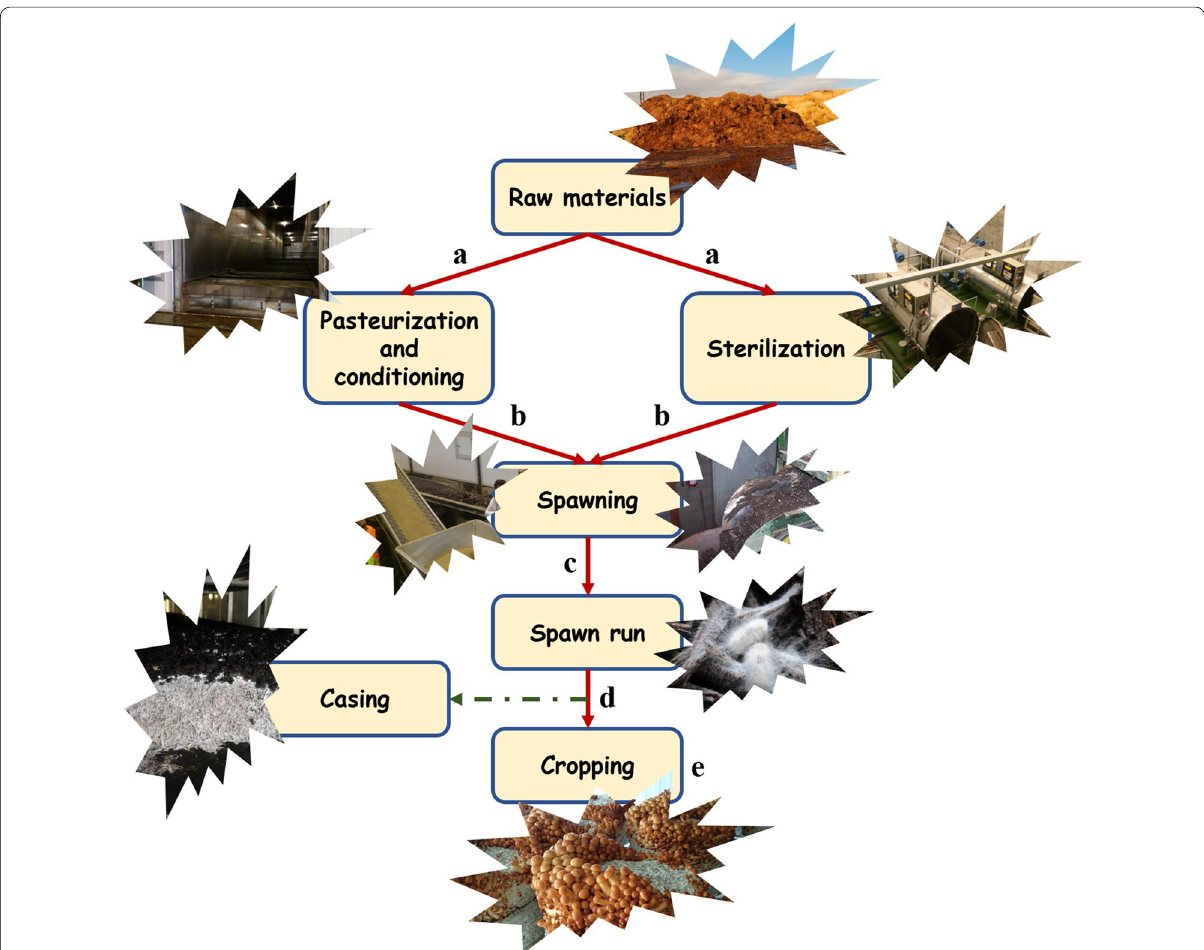
Fig. 1 Nutritional supplementation of substrates along different stages of mushroom cultivation. a Application to raw materials; b , c Addition during spawning (after pasteurization/sterilization of substrates); d Supplementation of colonized substrates; e Supplementation during the cropping